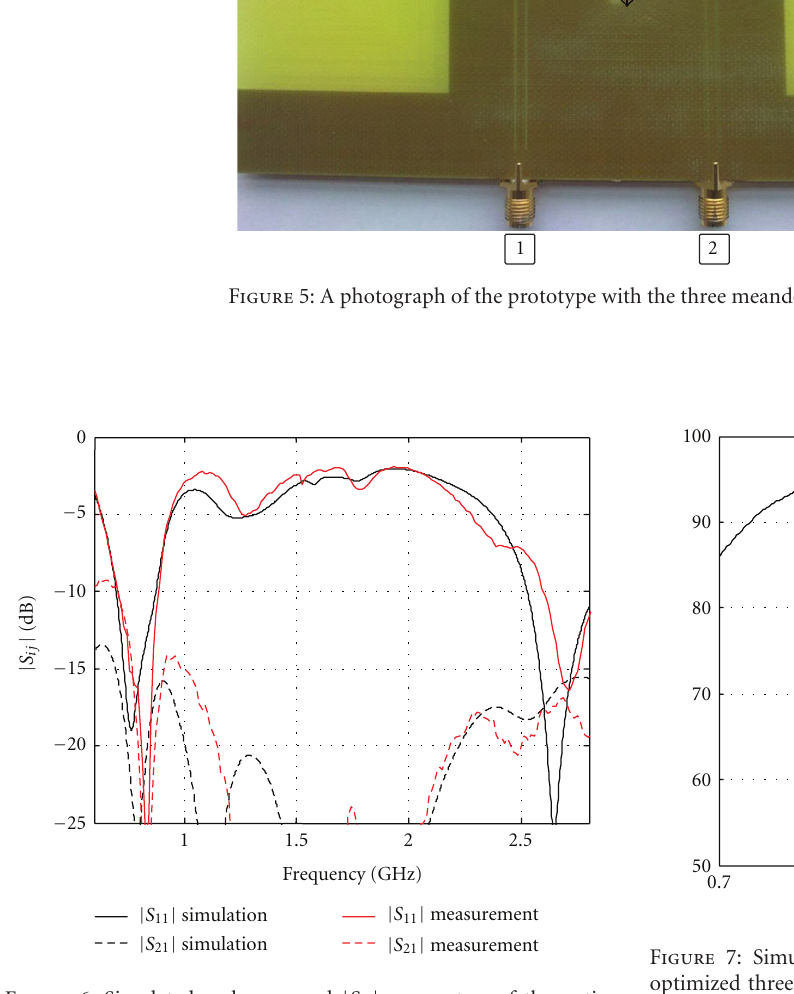
Figure 6: Simulated and measured | S ij | parameters of the opti- mized three bend endings antennas with added ground plane and slot.